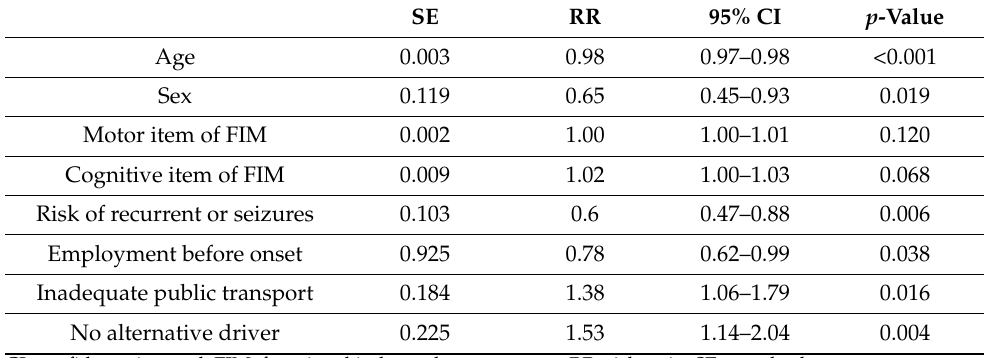
Table 2. Log-binominal analysis of factors predicting resuming driving after brain